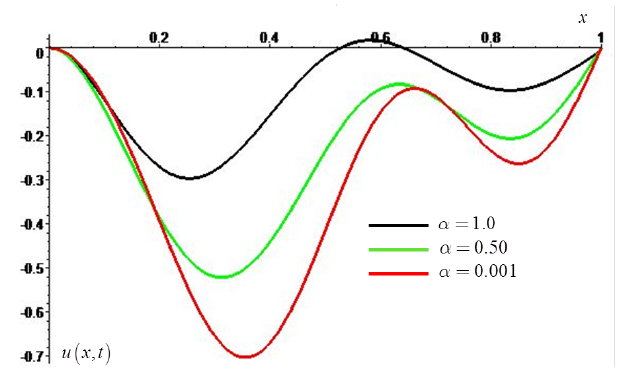
Fig. 2. The deflection due to the homogeneous solution for various nonhomogeneity parameters ˛ .